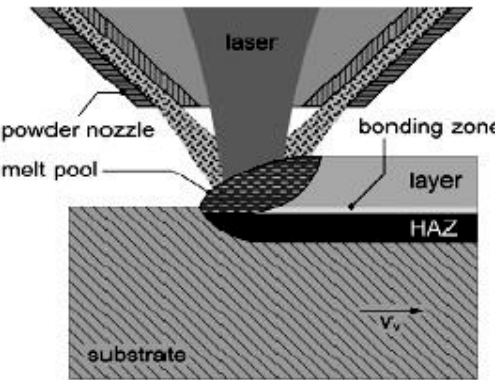
Figure 4. Schematic diagram of the laser cladding process [37]. Reprinted with permission from [37]; 2017 Elsevier.